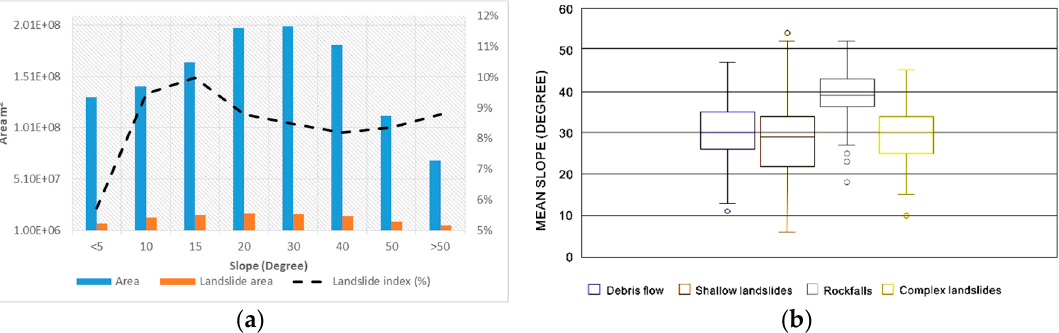
Figure 11. Average values of the total surface, landslide area, landslide index (ratio in percentage between landslide area and total area in each slope class) for the slope gradient ( a ), box plot of the mean slope of each landslide for the inventory and different landslide types ( b ).